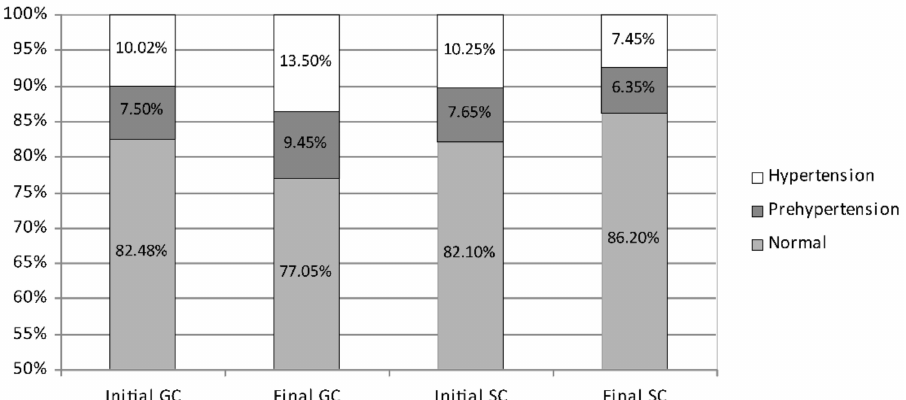
Figure 3. The percentage of boys with systolic prehypertension, hypertension, and normal blood pressure—comparison between the initial and the final measurement sessions. GC—general educa-